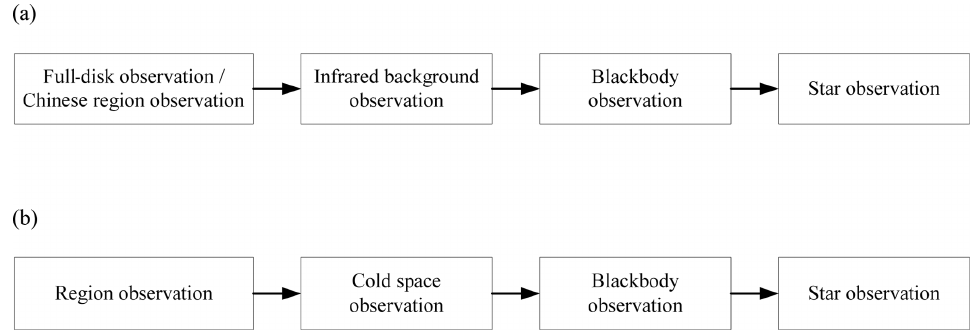
Figure 4. Time blocks for AGRI and GIIRS used in daily operation: (a) AGRI and (b) GIIRS.